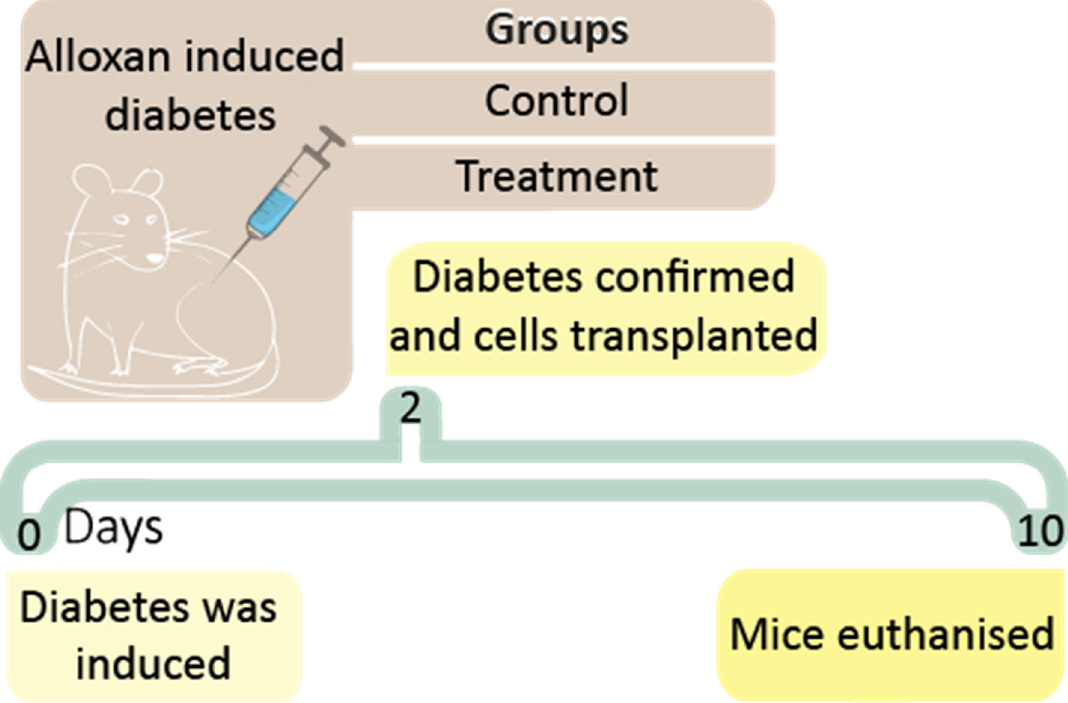
Figure 2. Timeline for the in vivo study to examine the therapeutic effect of transplanted PB-islet microcapsules.